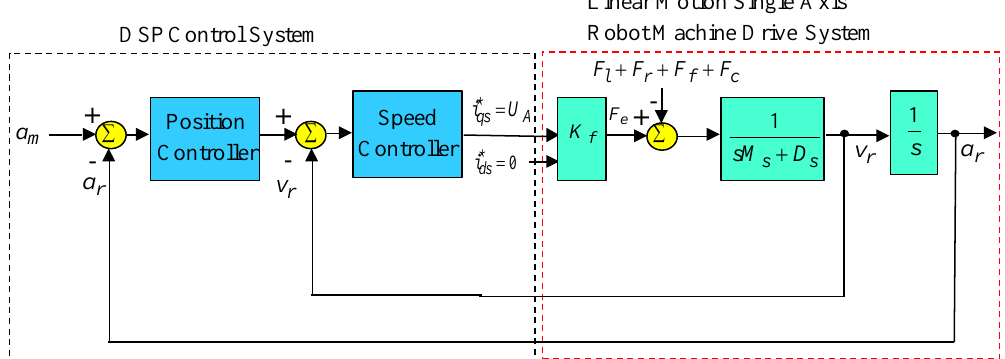
Figure 1. Makeup of linear motion single axis robot machine and drive system.